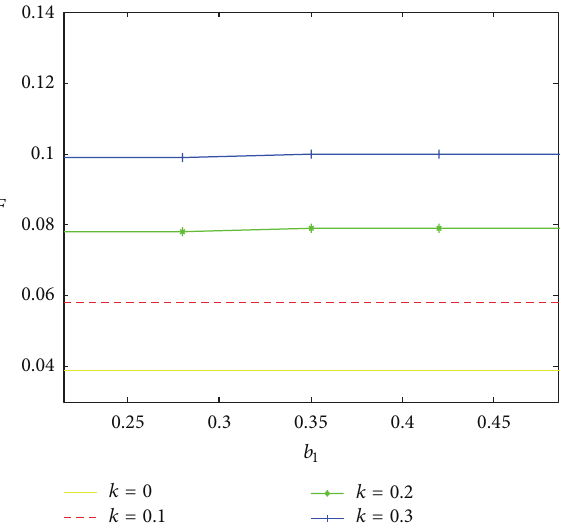
Figure 5: Impact of 𝑎 1 on sampling level.